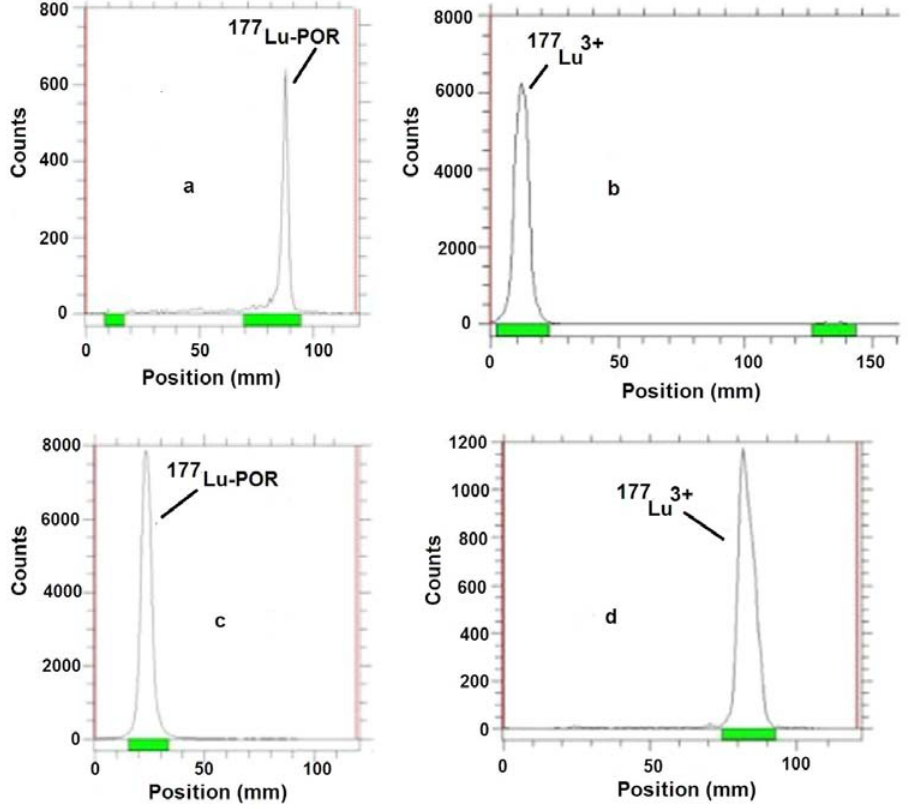
and 177 Lu-TTP on Whatman No. 2 paper using water:acetonitrile (1:3) [up (a & b)] FIGURE 6 - ITLC chromatograms of 177 LuCl 3 and acetonitrile:water (1:3) [down (c & d)]